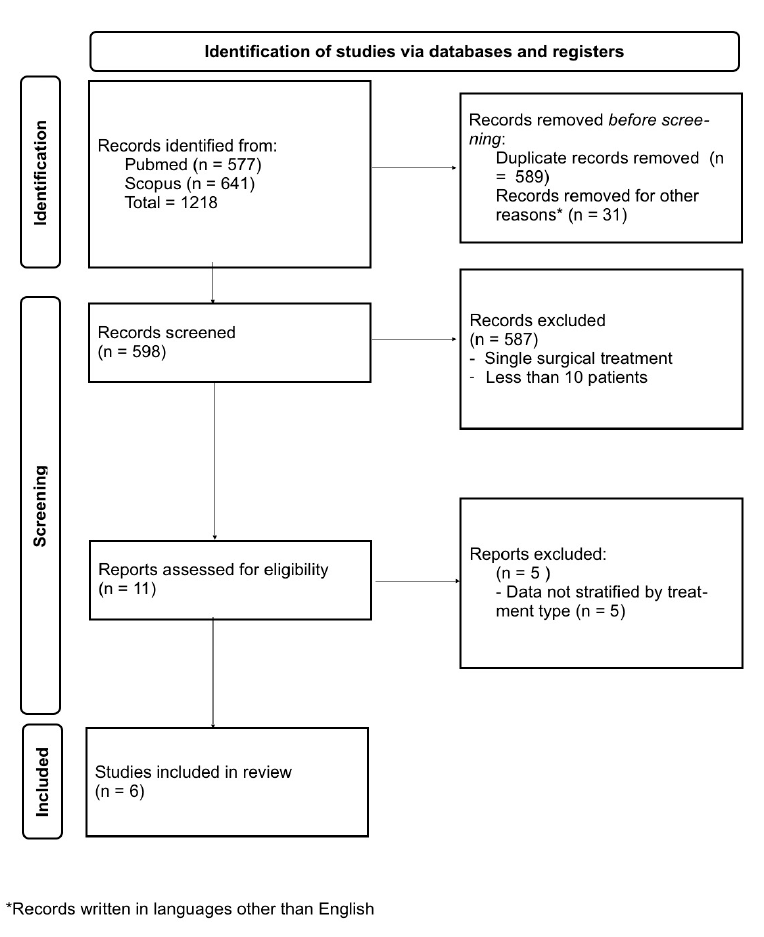
Figure 1. Analysis according to the PRISMA guidelines. Table 1. Summary of the studies comparing posterior lumbar decompression with lumbar decompression and fi xation for the treatment of lumbar synovial cysts included in the meta-